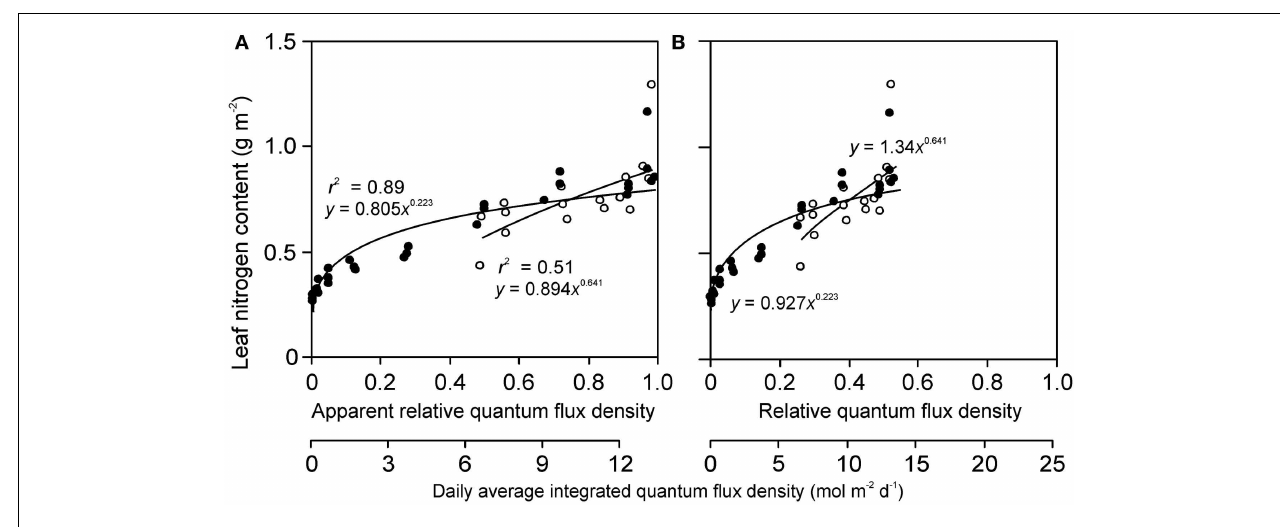
( R Q,A ) due to reduction of ambient solar radiation by greenhouse roof and walls (greenhouse wall transmittance κ Q ). As the actual relative quantum flux density (relative to full sun outdoors), R Q , is always less than R Q,A , R Q = κ Q R Q,A , the data expressed in relation to true relative light are compressed compared with the data expressed relative to R Q,A .The absolute light scale is also shown for both panels to underscore this fact. Data were fitted by power regressions that yielded the highest degree of explained variance for the given